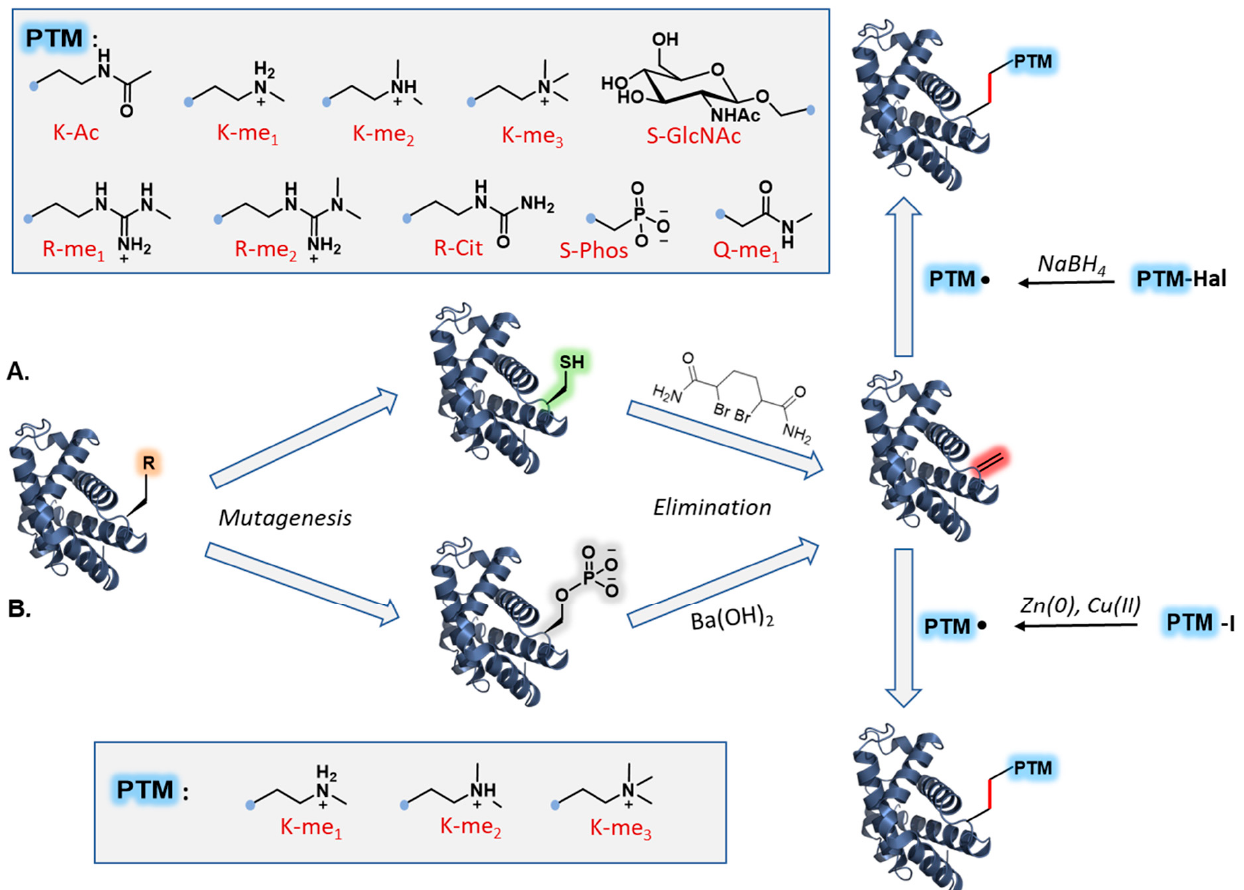
Figure 6. Chemical mutagenesis via carbon–carbon bonding reactions. ( A ) Chemoselective transfer of multiple PTM mimics via Cys elimination followed by radical additions: mono-/di-/trimethylation, acetylation, citrullination, glycosylation, and phosphorylation. ( B ) Chemoselective transfer of Lys PTM mimics via pSer elimination followed by radical additions: mono-/di-/trimethylation. In 2020, Davis and coworkers introduced a robust alternative strategy to incorporate a range of challenging functional groups and PTMs into recombinant proteins through carbon–carbon bond formation using a single-electron transfer method (Figure 7A) [81]. The authors described a visible-light-driven installation of several natural and non-natural side- chains, as well as PTMs, at Dha-tagged proteins under mild conditions. The Dha-tagged proteins reacted in the presence of Ru(II) photocatalysts with blue LED light (450 nm) to enable carbon–carbon bond formation in high fidelity. Like the previous methods, the reaction was driven by radical generation from radical precursors such as boronic acid catechol ester or pyridylsulfonyl derivatives coupled with Fe(II). These conditions enabled the versatile transfer of a broad range of native and modified amino-acid side-chains (>50 unique analogs) into a set of recombinant proteins. Importantly, this approach allowed for the insertion of several PTM analogs into histone proteins with acetyl-, methyl-, and benzyl-Lys mimics to probe the interaction of posttranslational enzymes (e.g., readers and erasers) and modified